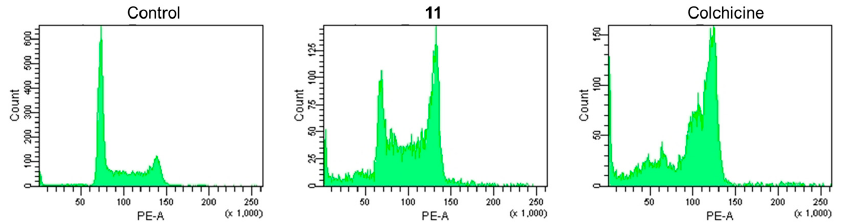
Figure 3. Effects of 11 or colchicine on cell cycle progression in HL-60 cells. Cell cycle distribution in HL-60 cells after treatment with 10 µM of 11 or 1 µM of colchicine for 20 h.